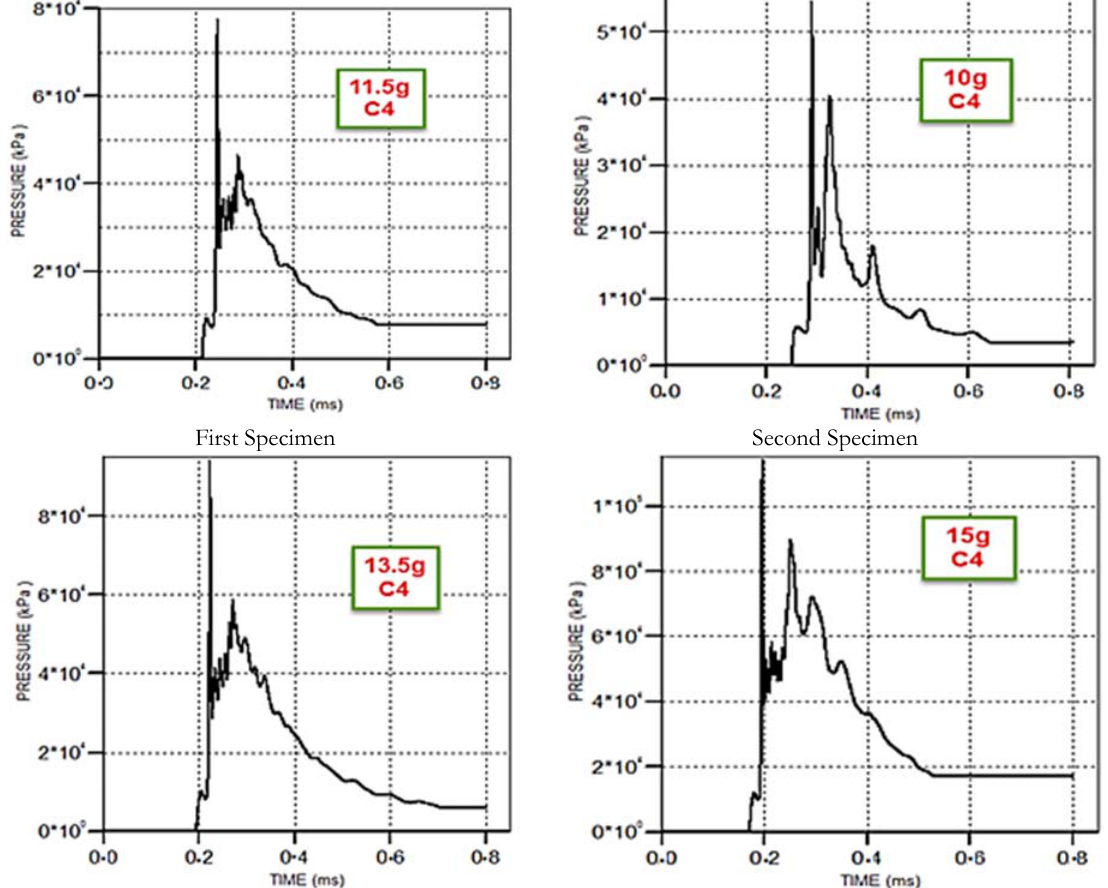
Figure 19: Shock wave diagram in the center of the sheet .